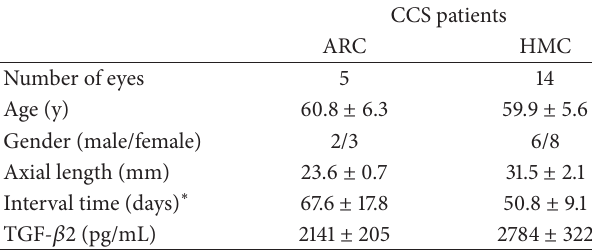
Table 2: Clinical profile of CCS patients.